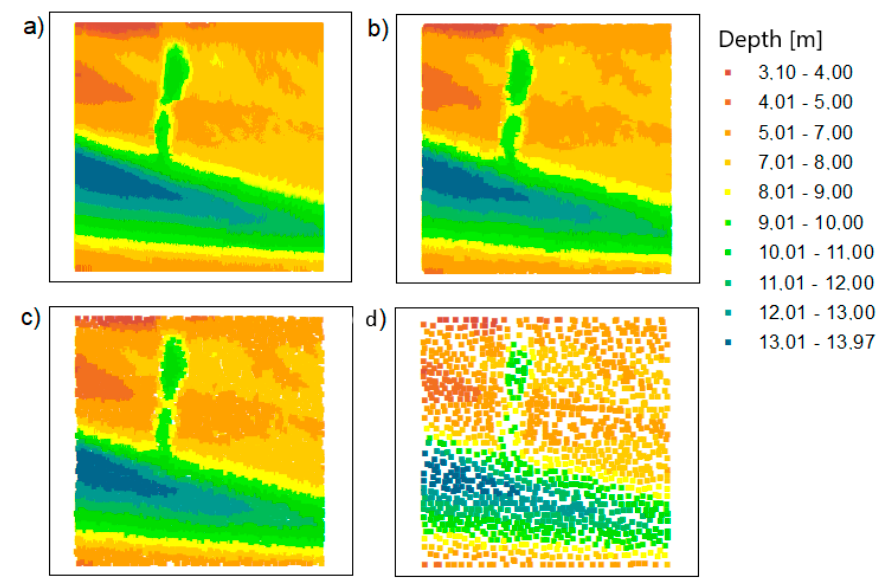
Figure 5. The points based on the Inski canal area: ( a ) raw data; ( b ) dataset reduced with the TBDRed method for setting no. 1; ( c ) dataset reduced with the TBDRed method for setting no. 2; ( d ) dataset reduced with the TBDRed method for setting no. 3.